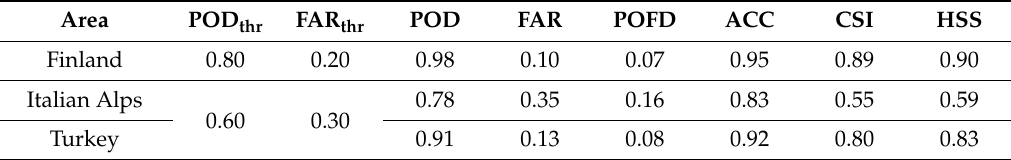
Table 11. Comparison between S-2-based snow masks and H10 product — Median values of evaluation metrics throughout the whole analysis period. H10 product requirements for both flat/forested (i.e., Finland) and mountainous areas (i.e., Italian Alps, Turkey) (POD thr and FAR thr ) are reported [104].